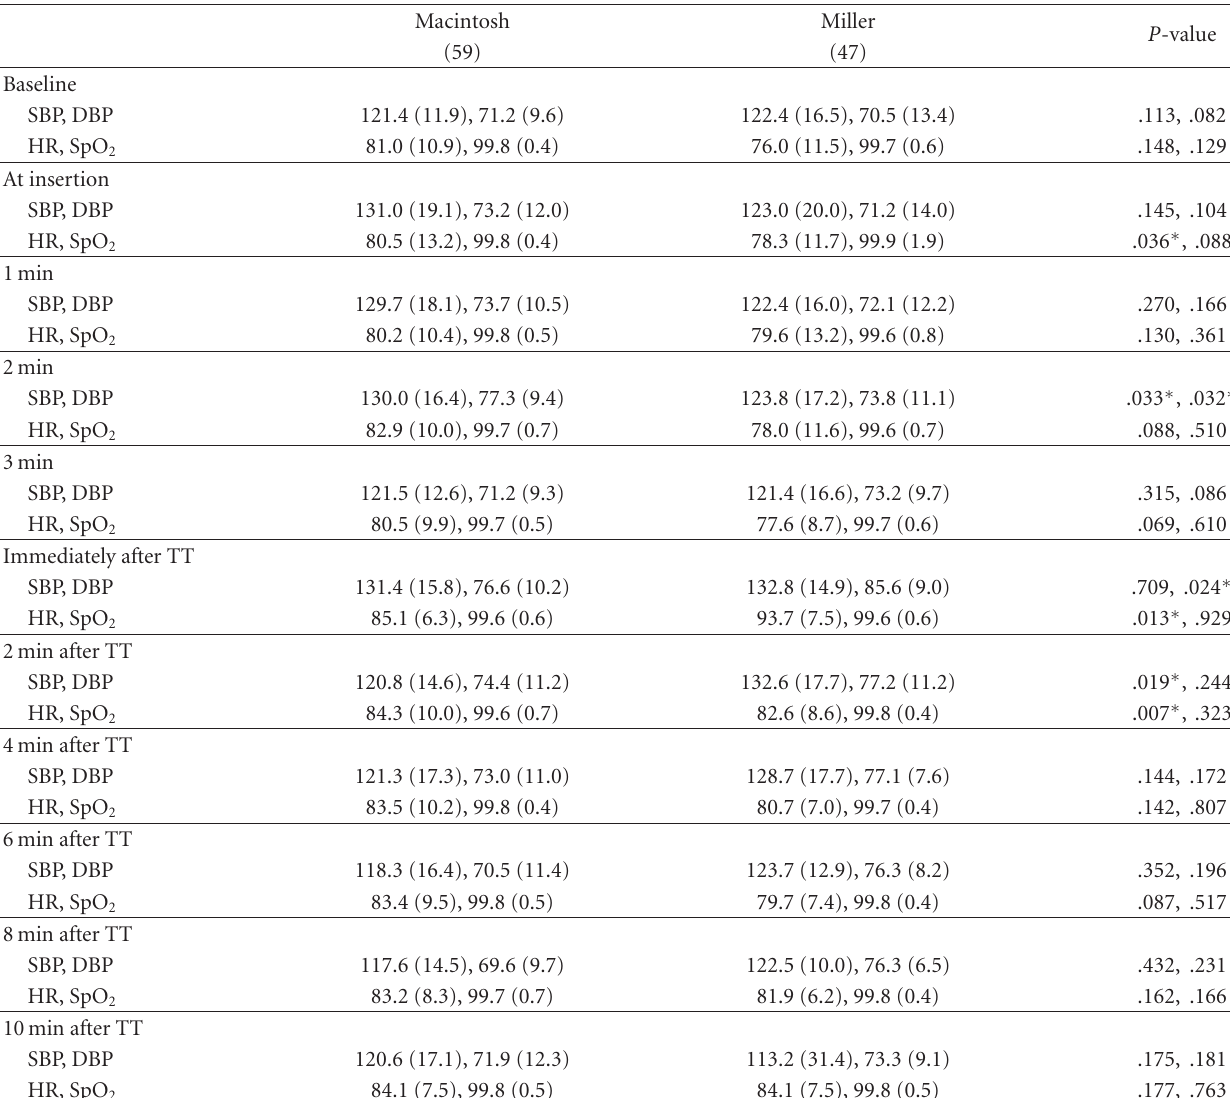
Table 3: Hemodynamic parameters: systolic and diastolic blood pressure (mmHg), heart rate (beat/minute), and oxygen saturation (SpO 2 , %) (mean,